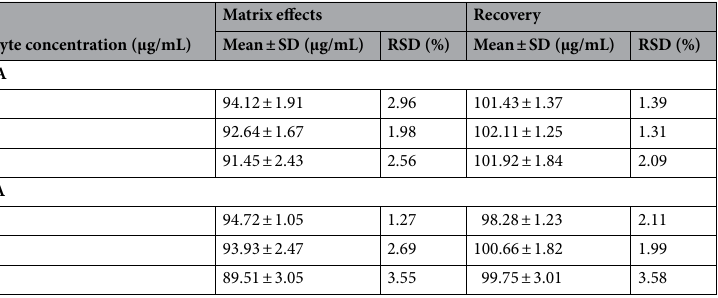
Table 3. Recovery and matrix effects of c POA and t POA in serum samples (n = 6). RSD relative standard deviation.